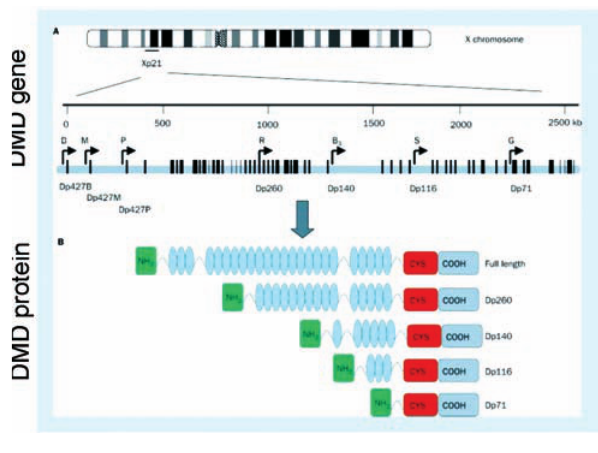
Figure 1. Schematic representation of dystrophinopathic car- diomyopathy and its stages. Figure 2. Schematic representation of dystrophyn gene and